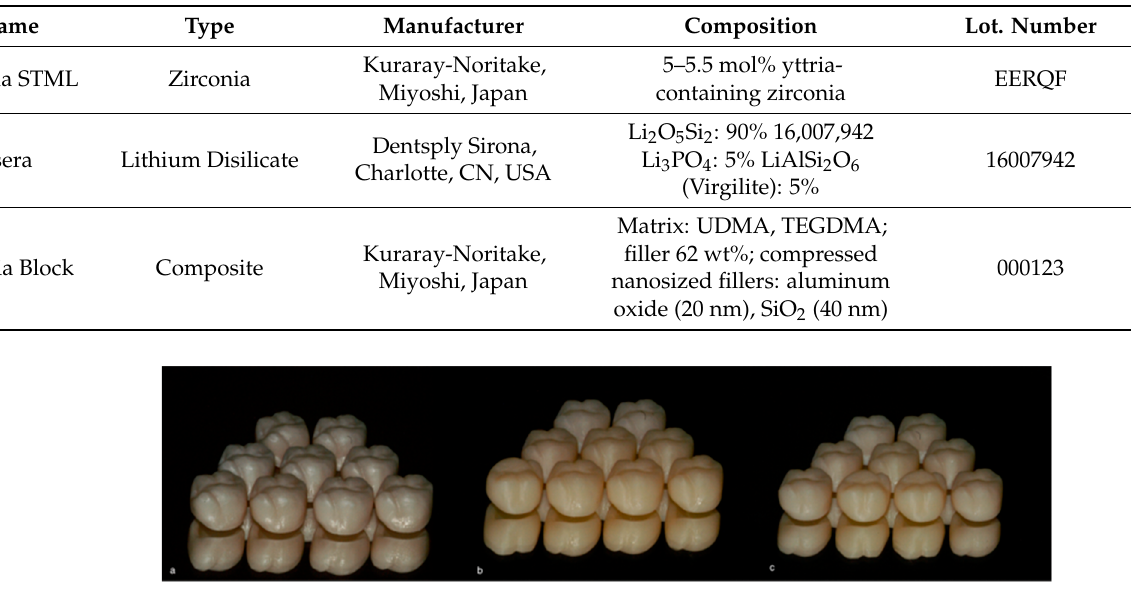
Table 1. Composition of the investigated materials.